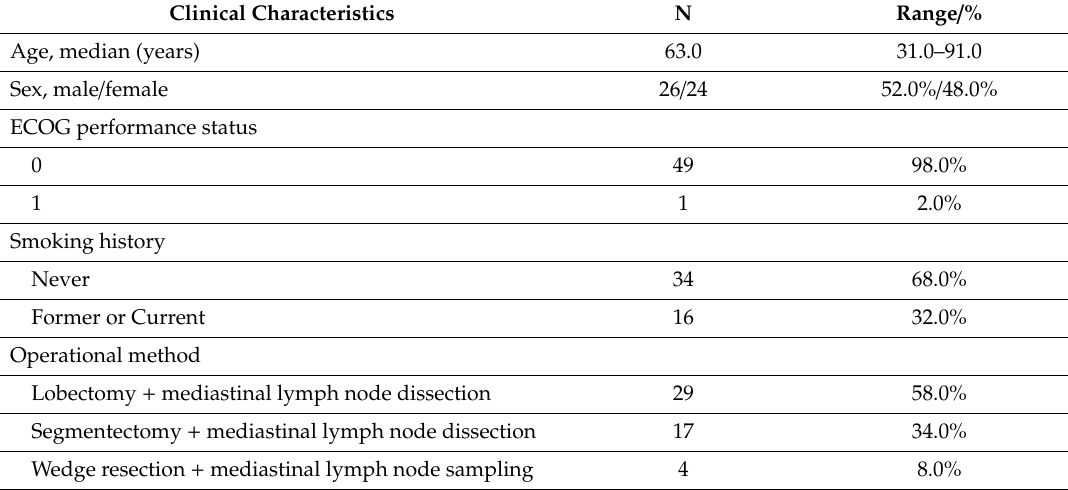
Table 1. Basic characteristics of enrolled patients. ECOG, Eastern Cooperative Oncology Group;